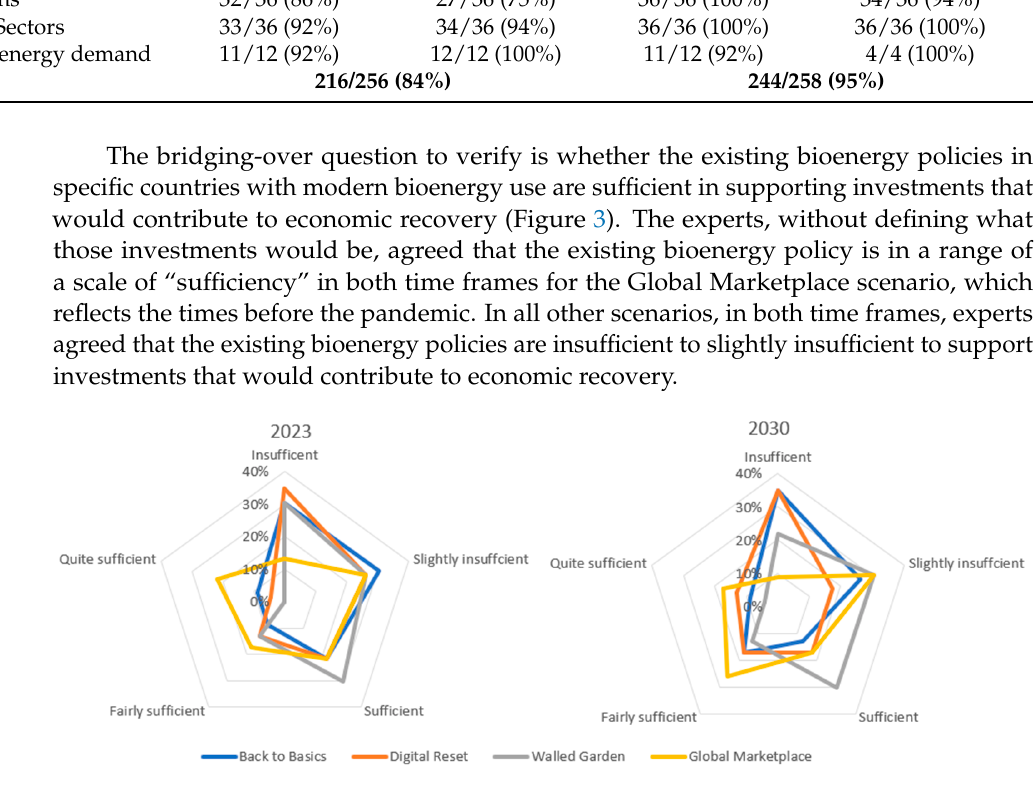
Figure 3. Experts’ opinion if the existing bioenergy policies in their countries are sufficient in supporting investments that would contribute to economic recovery.